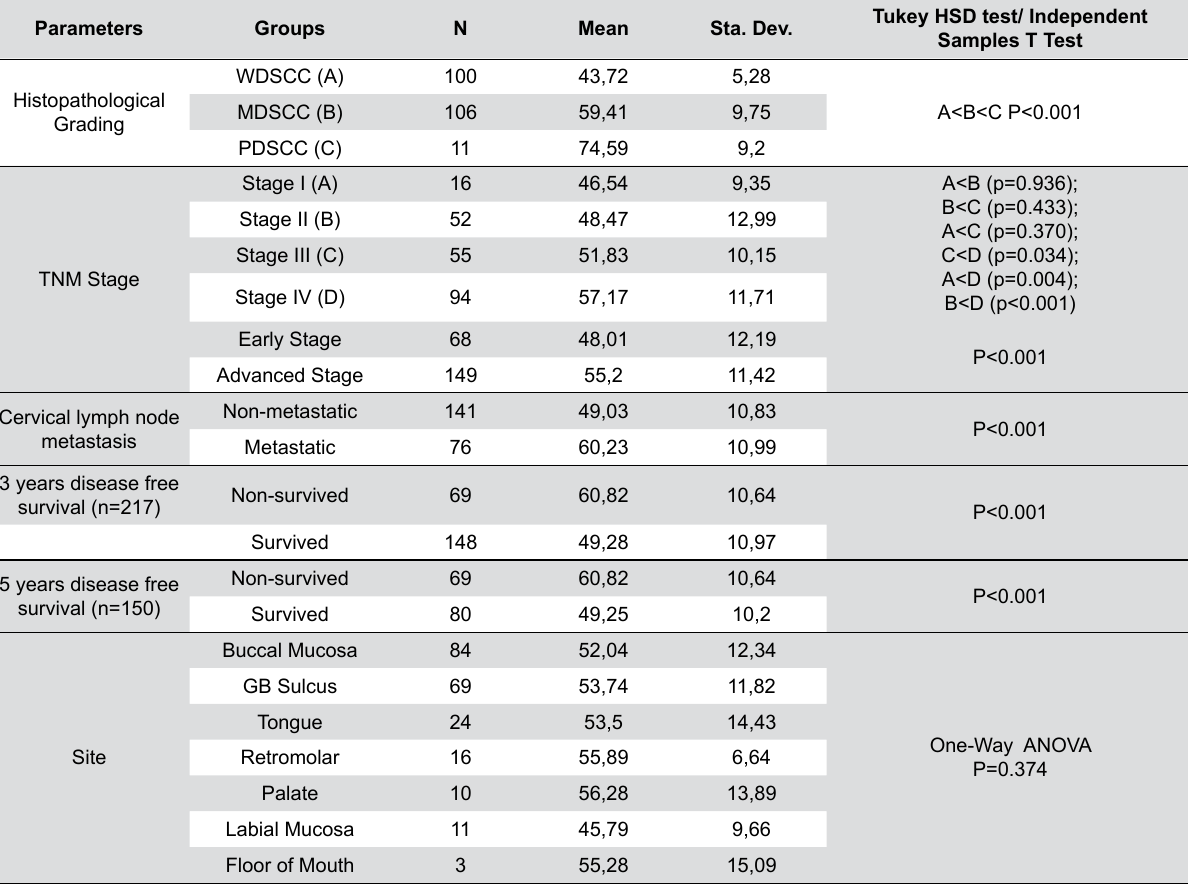
Table 2- Comparative analysis of Ki67 labeling index in clinicopathological and survival of all Oral squamous cell